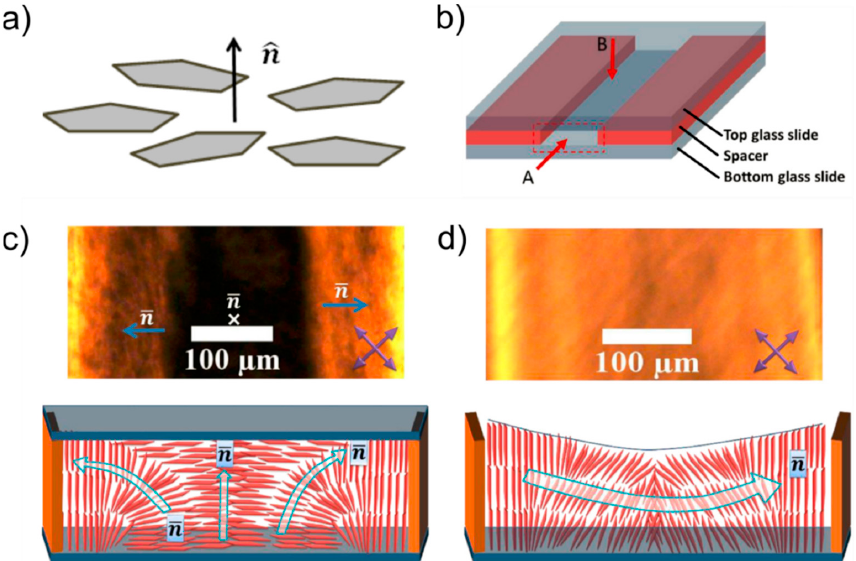
Figure 8. ( a ) Schematic diagram showing the orientation of GO flakes with respect to the director, n. ( b ) The confining geometry used to photograph GO dispersions (POM) in parts ( c , d ). In ( c ) the top glass plate is present and the LC becomes homeotropic in the centre of the channel. In part ( d ) the top plate is removed and the boundary conditions are set by the vertical walls. The director configurations